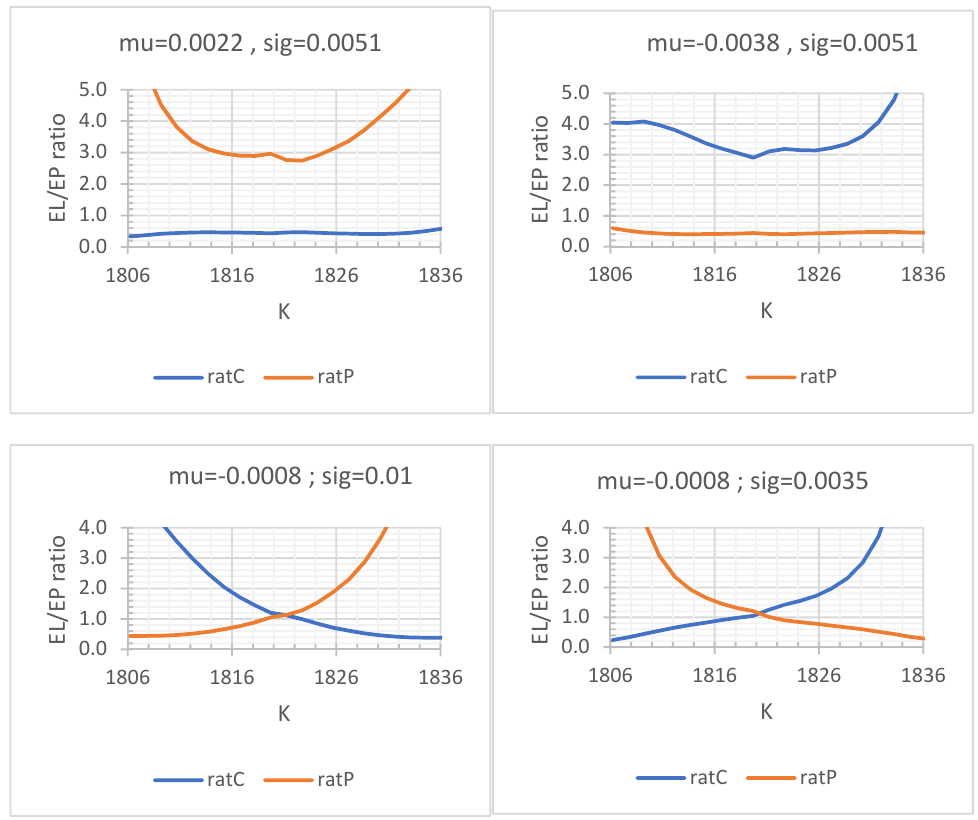
Figure 4. Effects on EL/EP ratios when varying drift and volatility parameters of the GBM model for Nadex Gold data of 8 February 2022.